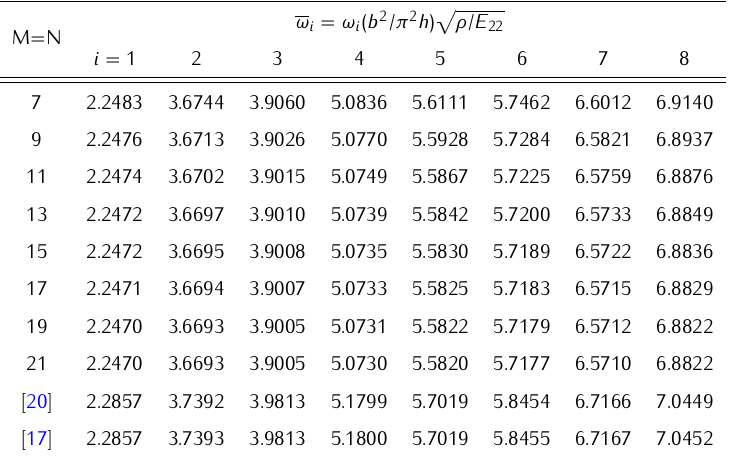
Table 5. The first eight natural frequency parameters ( ω ( 45 ◦ / − 45 ◦ / 45 ◦ / − 45 ◦ / 45 ◦ ), ( h/b = 0 . 1 , k = 5 / 6 , a/b = 1